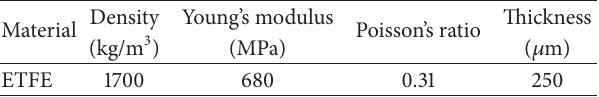
Table 4: Sensitivity of inflatable tube to imperfection magnitudes.